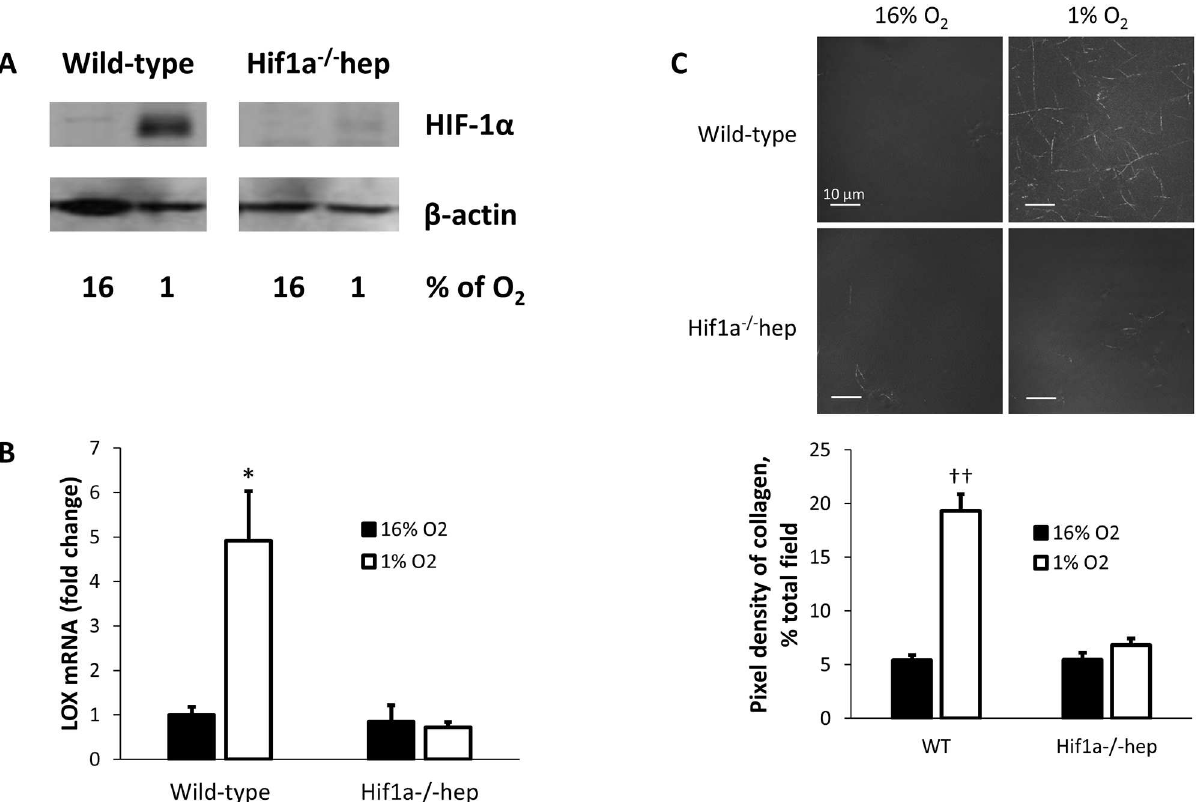
Fig 1. Hypoxia accentuatesLOX expression via HIF-1, leading to enhanced collagen cross-linking. (A) Hypoxicexposure increases expressionof HIF-1 α in the nuclear extract of wild-typemouse hepatocytes. This changeis abolished in hepatocytesfrom Hif1a -/- hep mice. (B) LOX mRNA expressionincreasesin wild-typehepatocytes exposedto hypoxia,but this increase in LOX is not observedin Hif1a -/- hep hepatocytes. (C) When culture media from wild-typehepatocytes is added to collagen,hypoxiacauses increasedcollagencross-linking and precipitation;this difference is not seen in Hif1a -/- hep hepatocytes. * , p < 0.05;††, p <